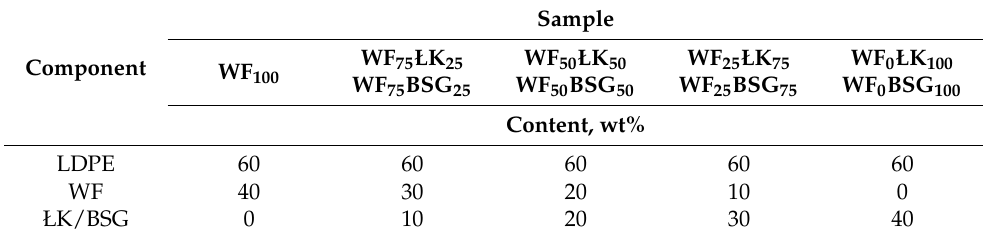
Table 2. Composition of prepared